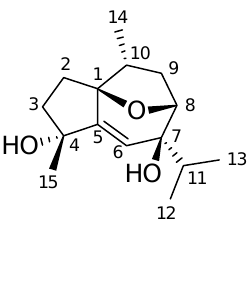
Figure 3. Structure of compound 1